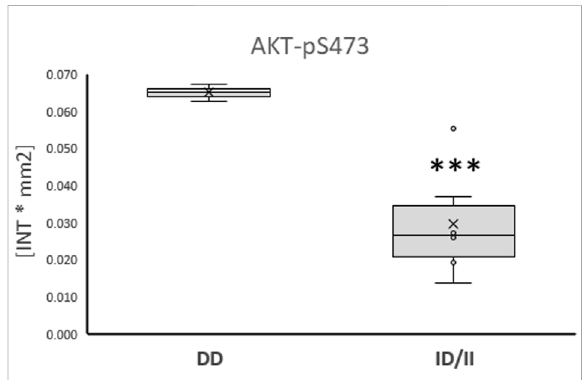
FIGURE 6 Phosphotransferase demonstrating ACE-I/D genotype related ‘ counter-regulation ’ post exercise. Box-Whisker plots of the (referenced) values for the phosphorylation of glucose metabolism related AKT-pS473 in the fi t carriers (ACE-ID/II) and non-carriers of the ACE I-allele (ACE-DD) ½ - 8 h after one- legged exercise. ***, p < 0.001 for differences vs. ACE-DD genotype. ANOVA for the factor ACE-I/D genotype.